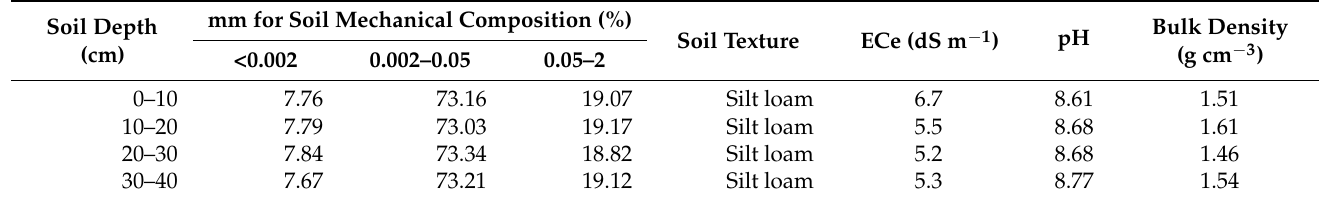
Table 1. The initial physical and chemical properties of the experimental